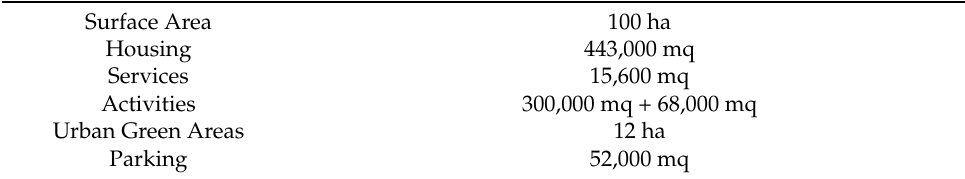
Table 10. The project. Source: Authors’ elaboration (2022) based on data from the site http://www. ecoquartiers.logement.gouv.fr (accessed on 19 June 2022).